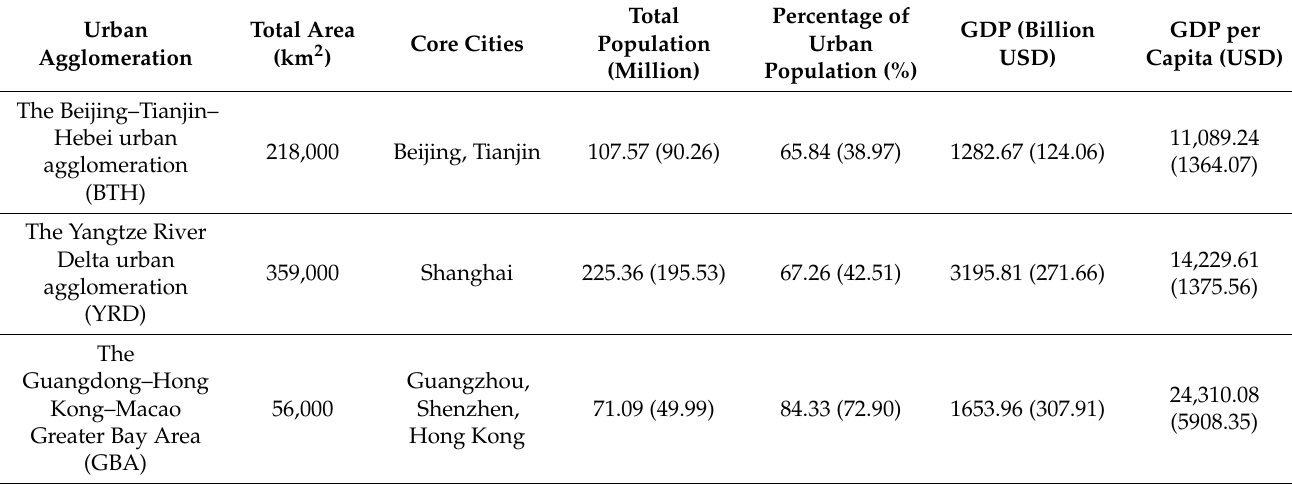
Table 1. Comparison of the socioeconomic statuses of the three most developed urban agglomerations in China in 2000 and